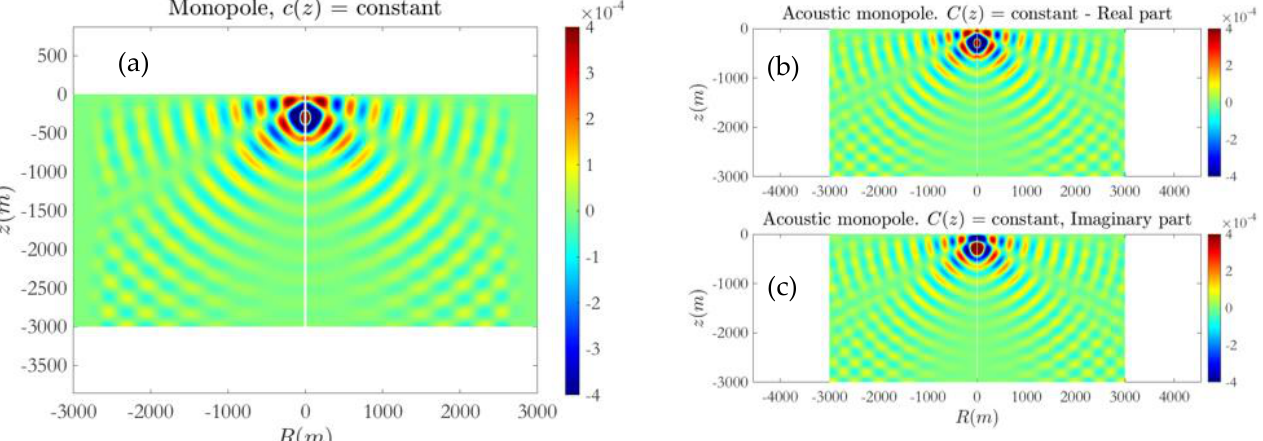
Figure 7. The acoustic field in the case of the isovelocity c = 1500 m/s environment, obtained using the present FDTD–PML numerical scheme, excited by a monopole source of frequency f = 5 Hz located at a depth of 300 m, after times of ( a ) 1 period, ( b ) 3 periods, ( c ) 7 periods, and ( d ) 14 periods from the beginning of the calculation.